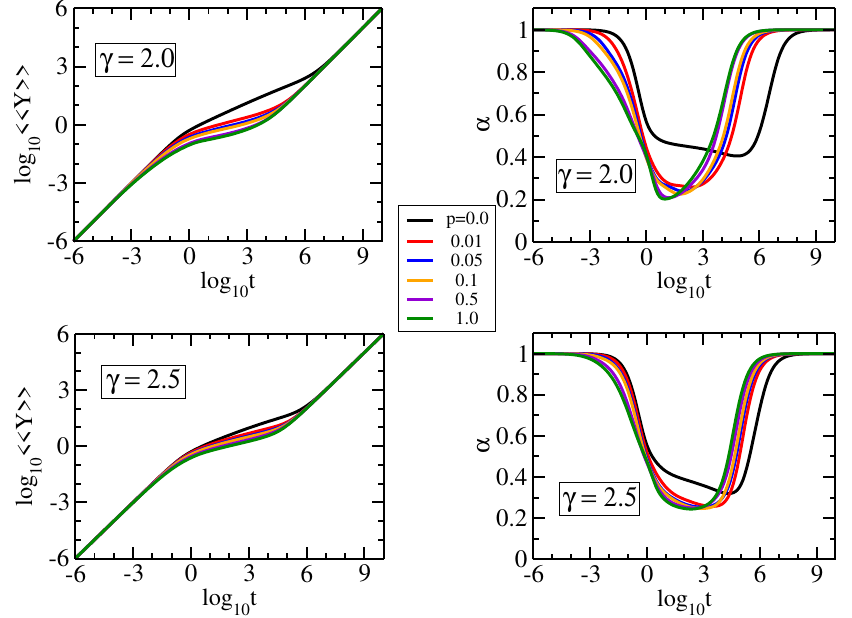
Figure 7. Average monomer displacement and its derivative for pDSFNs with N = 10,000 and various values of p and γ , as indicated. The time t has units of 1/ σ = ζ / K